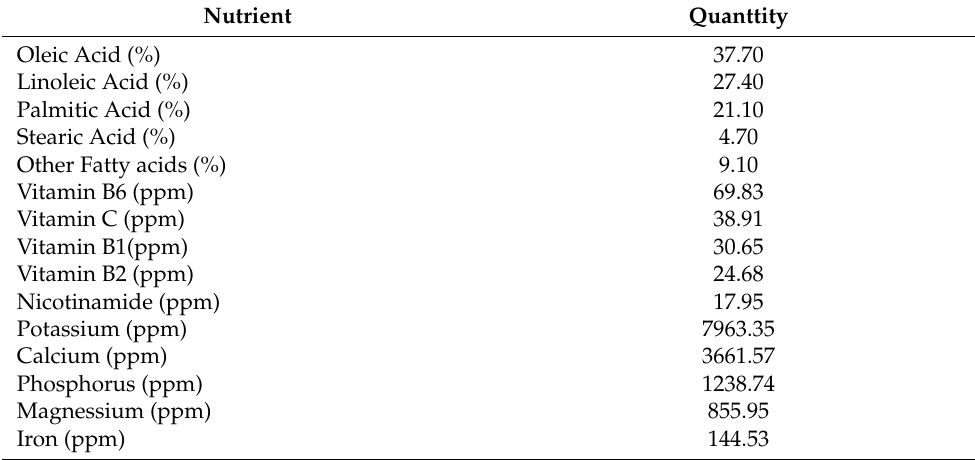
Table 2. Key nutrients in sumac